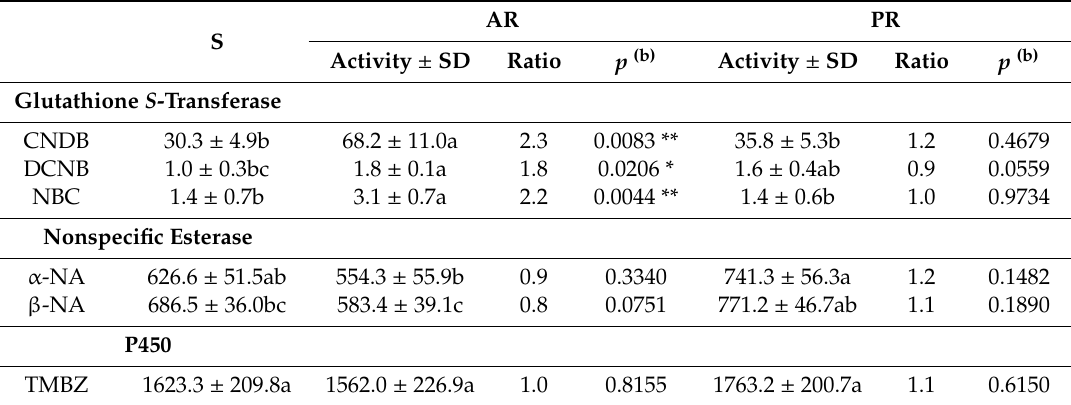
Table 5. Detoxifying enzyme activities in S, AR, and PR strains of Tetranychus urticae (a) .